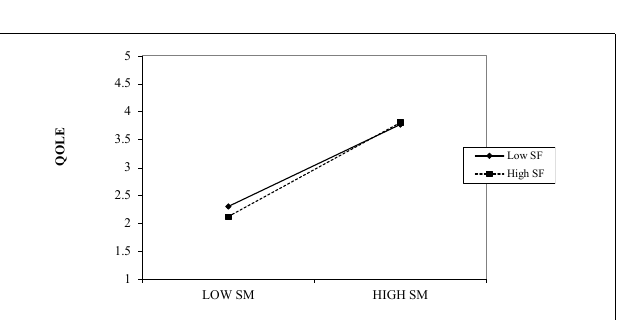
FIGURE 3 | Interaction of situational factors and motivational